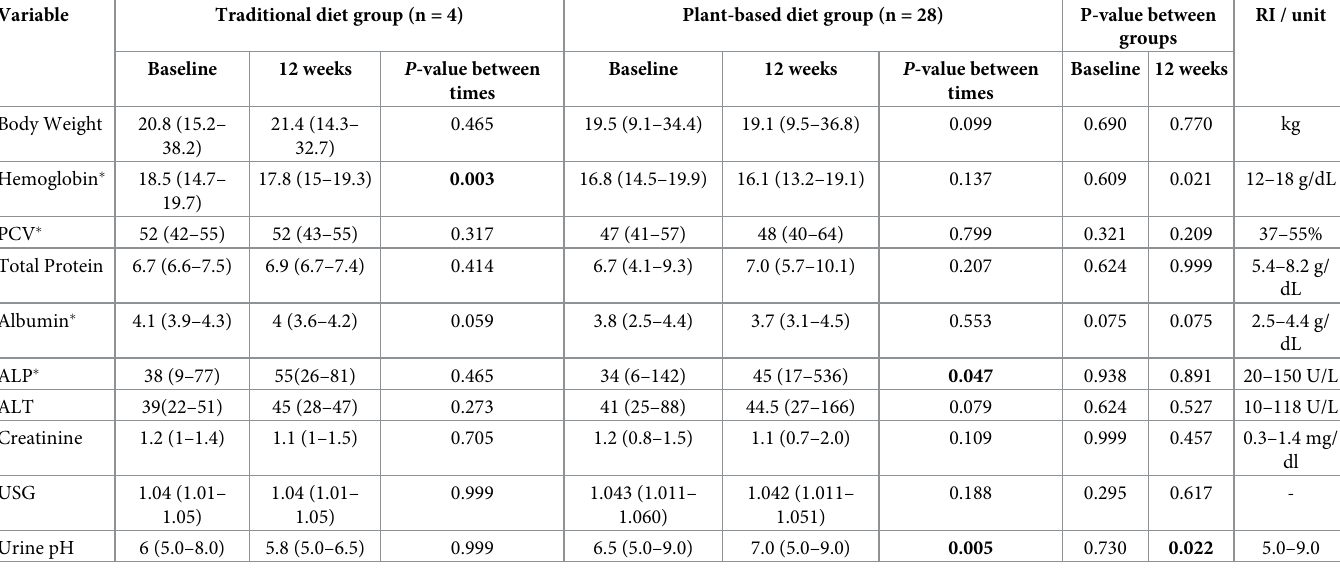
Table 2. Body weight and select hematologic and serum biochemical data in dogs at baseline and after being fed a traditional diet or a plant-based diet for 12 weeks.